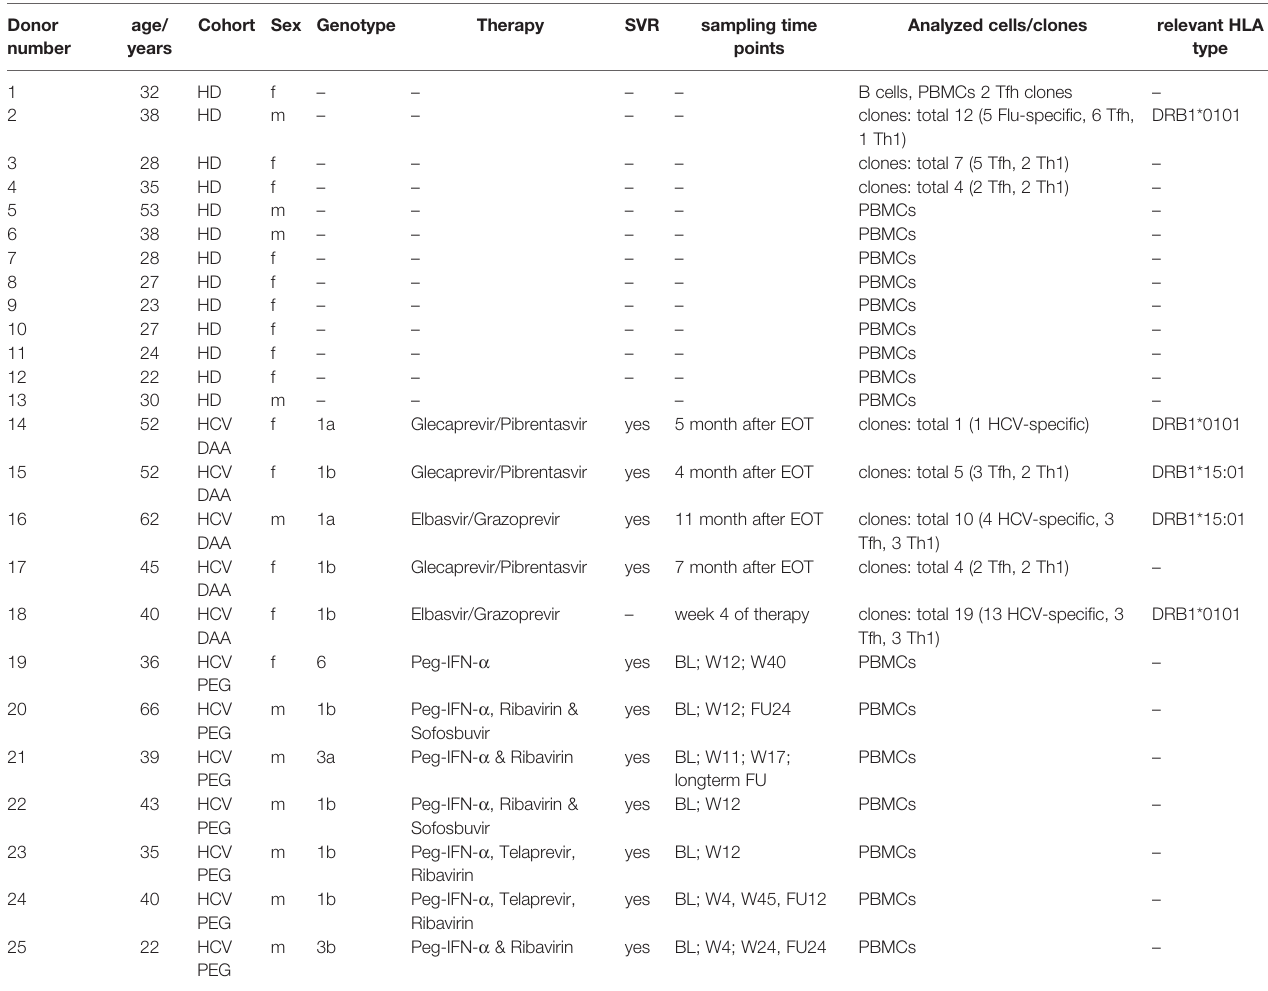
TABLE 1 | Study cohort and PBMC donors of cloned cells.